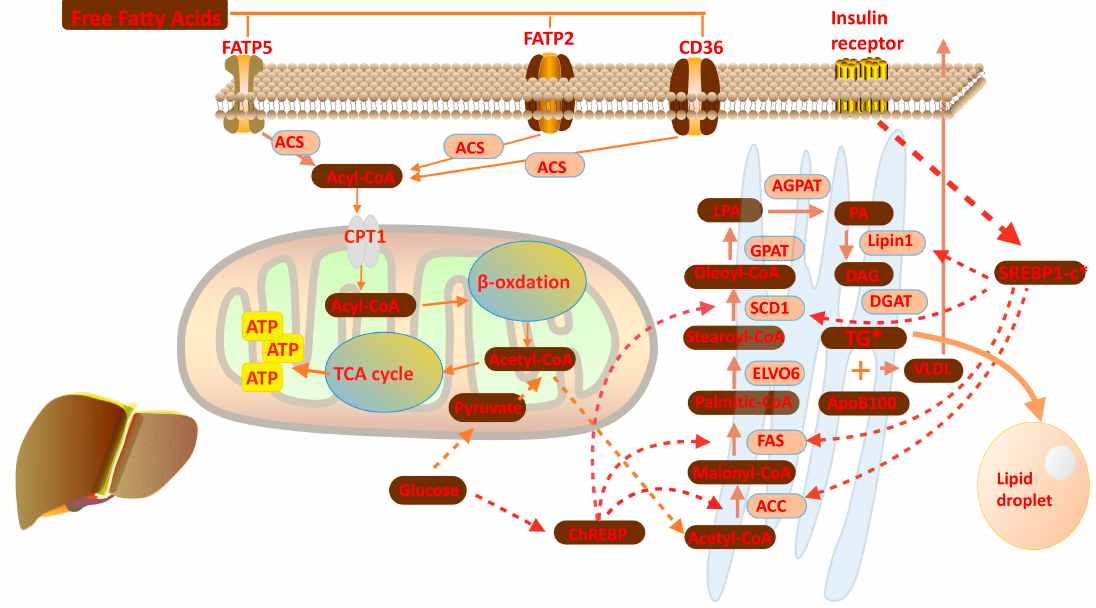
Figure 3. Overview of the lipid metabolism in the liver: Free fatty acids are used to synthesize acyl-CoAs after uptake into hepatocyte cell under the help of FATP family; Acyl-CoA transfer to mitochondria to participate β -oxidation, which finally produce acetyl-CoA; Acetyl-CoA are used to synthesis lipid in smooth endoplasmic reticulum.